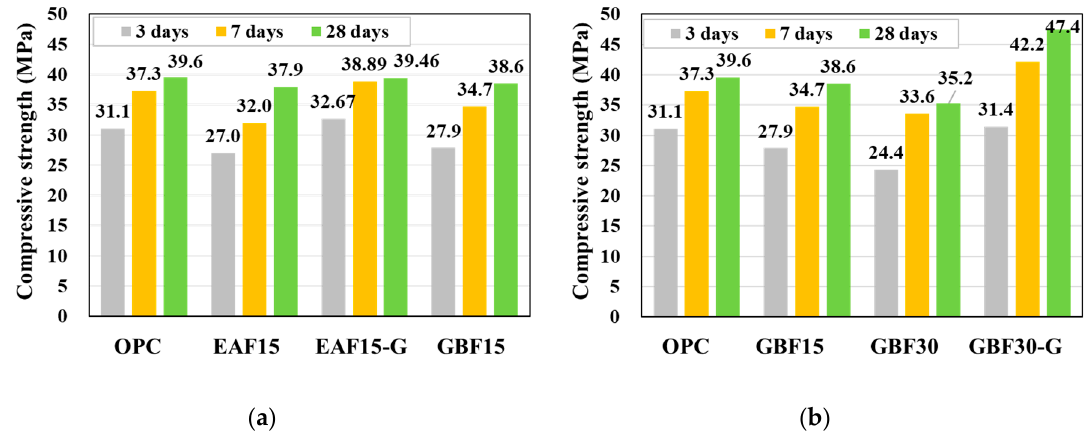
Figure 5. Compressive strength. ( a ) Results of EAF series and ( b ) results of GBF series.